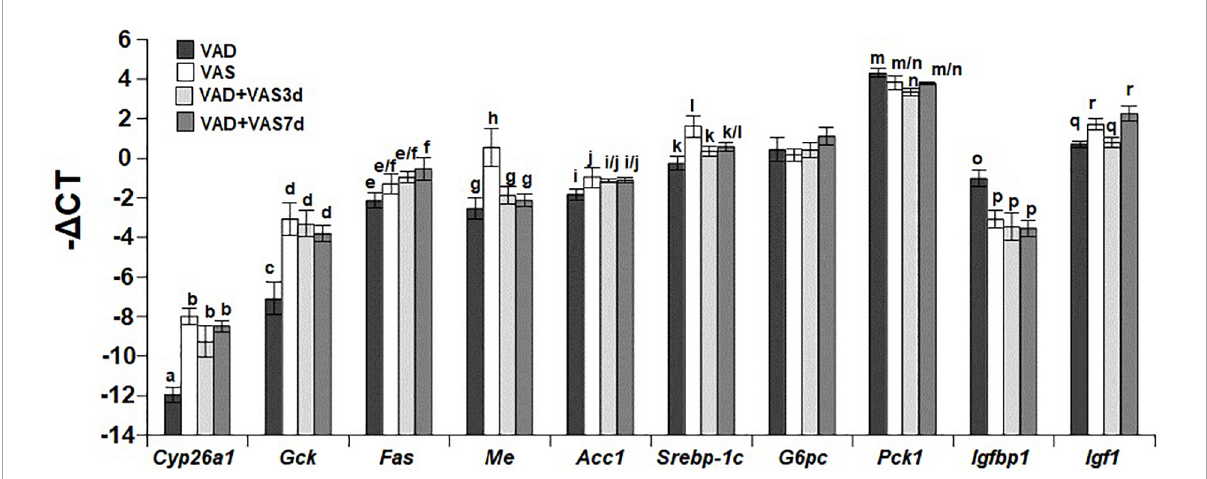
FIGURE2 The hepatic mRNA levels of Cyp26a1, Gck, Fas, Me, Acc1, Srebp-1c, G6pc, Pck1, Igfbp1, and Igf1 in Zucker lean (ZL) rats fed the vitamin A deficient (VAD) for 8 weeks, the vitamin A sufficient (VAS) diet for 8 weeks, or fed the VAD diet for 8 weeks followed by the VAS diet for 3 (VAD + VAS3d) or 7 (VAD + VAS 7d) days. Data are presented as mean ± SEM of minus delta Ct (cycle threshold); n = 7, 5, 5, and 5 for the VAD, VAS, VAD-VAS3d, and VAD-VAS7d, respectively; a < b for Cyp26a1 (cytochrome P450 26a1), c < d for Gck (glucokinase), e < f for Fas (fatty acid synthase), g/h for Me (malic enzyme), i < j for Acc1 (acetyl CoA carboxylase alpha), k < l for Srebp-1c (sterol regulatory element-binding protein 1c), m > n for Pck1 (cytosolic form of phosphoenolpyruvate carboxykinase), o > p for Igfbp1 (insulin like growth factor-binding protein 1), q < r for Igf1 (insulin-like growth factor 1); all P < 0.05.